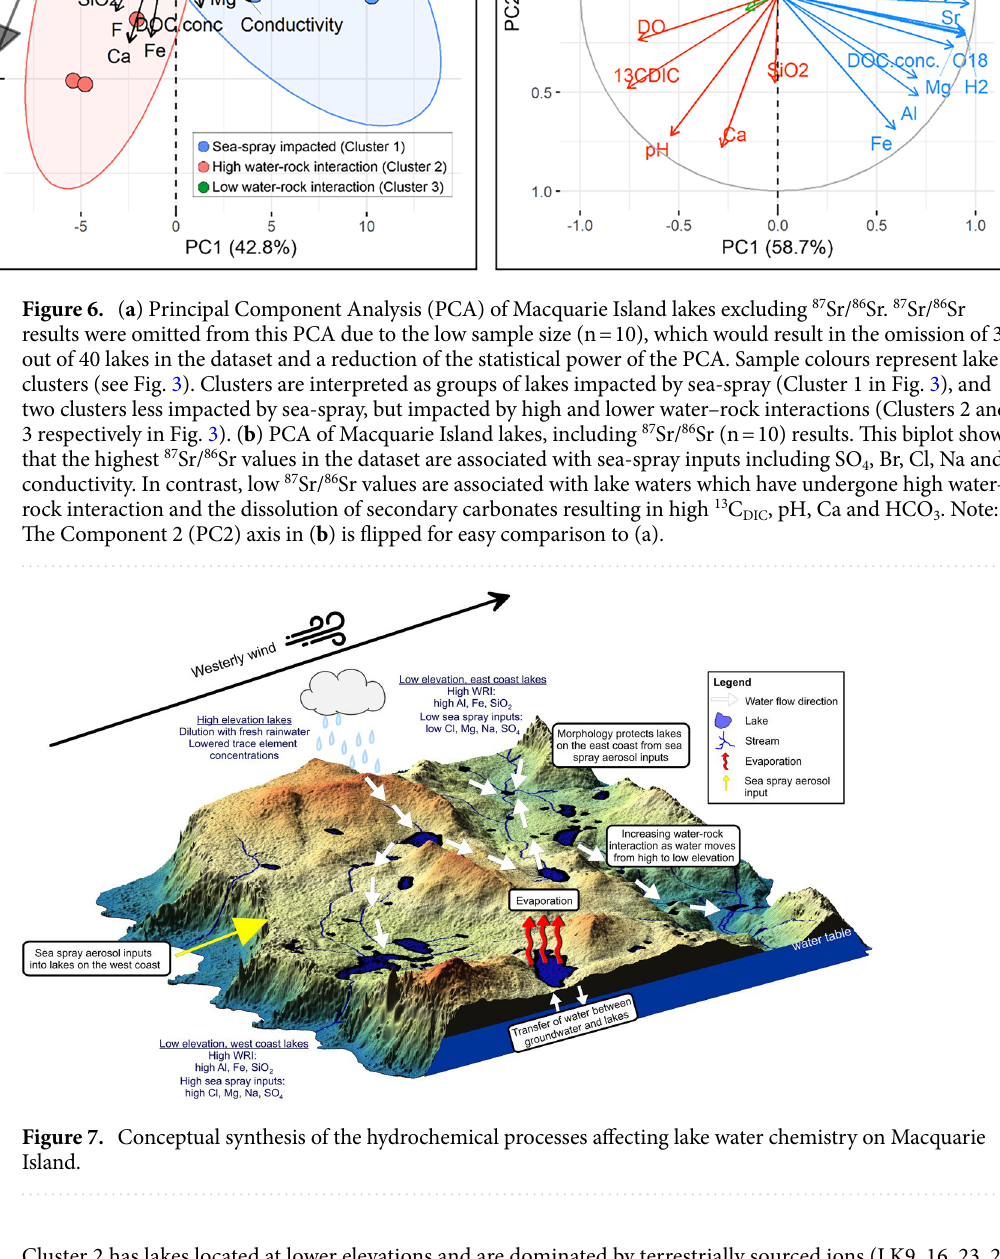
soil organic matter and DOC values in lake waters suggests limited in situ biological processing in the lakes.